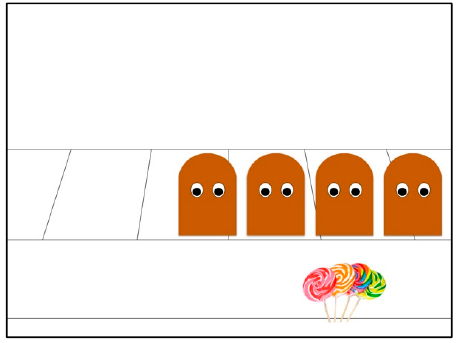
Figure 1. Acceptance scene outcome.